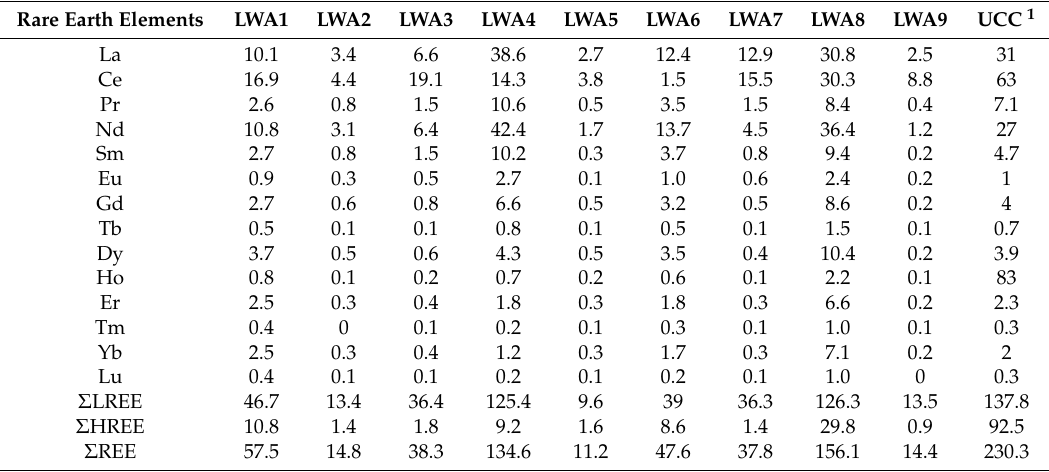
Table 6. Rare earth element composition in ppm of the clay size fraction of the Zebediela kaolin. Rare Earth